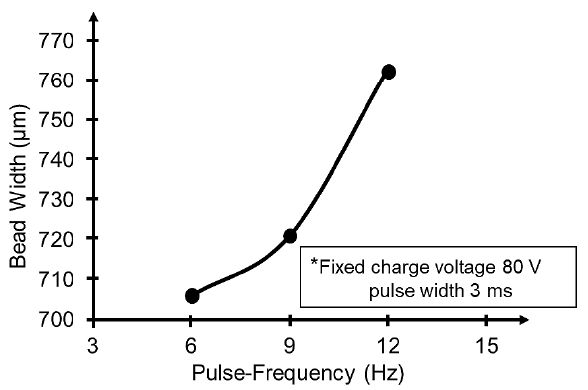
Figure 10. E ff ect of pulse frequency on weld bead Figure 10. Effect of pulse frequency on weld bead width.